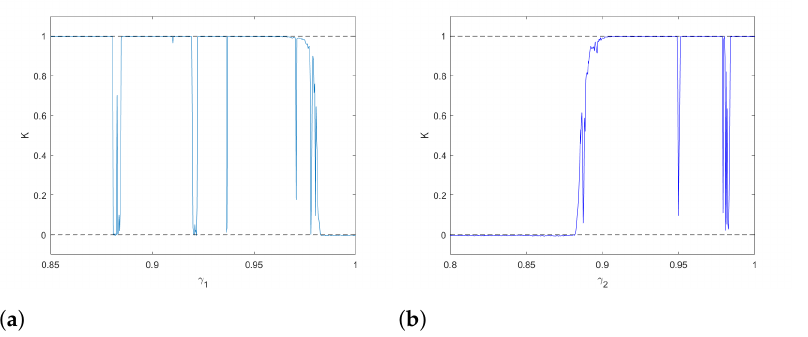
Figure 14. The asymptotic growth rate K of the fractional discrete SIR epidemic model (11) with ( γ 1 , γ 2 ) as critical parameters for ( a ) γ 2 = 0.94, ( b ) γ 1 =